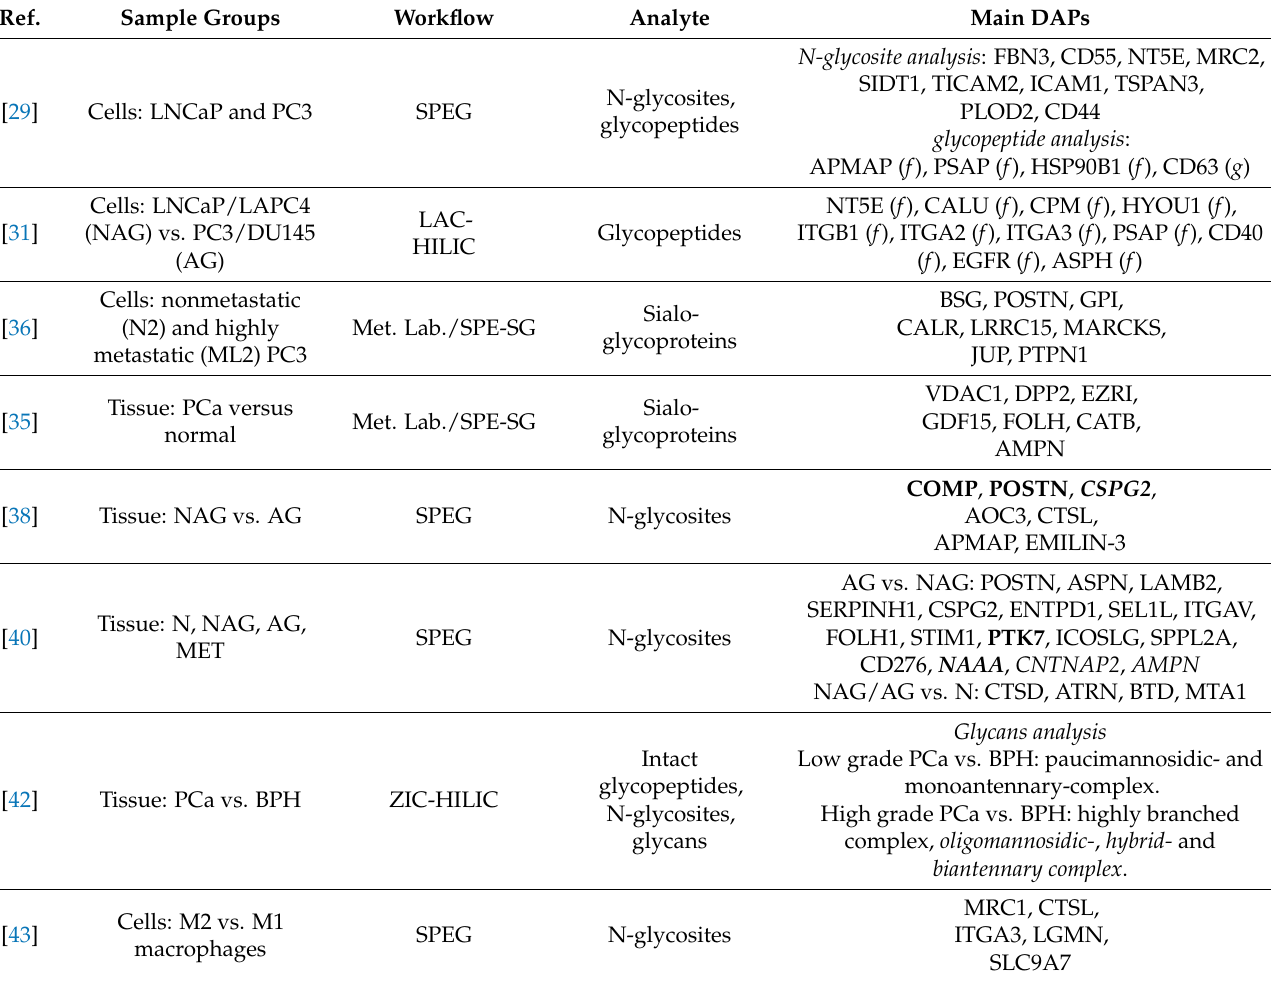
Table 1. Main differentially abundant glycoproteins (DAPs) identified in cell cultures or PCa tissue by MS-based workflows. Plain text = discovery level; bold character = validation level; italic = protein is downregulated; ( f ) core-fucosylated glycopeptide; ( g ) glycopeptide.